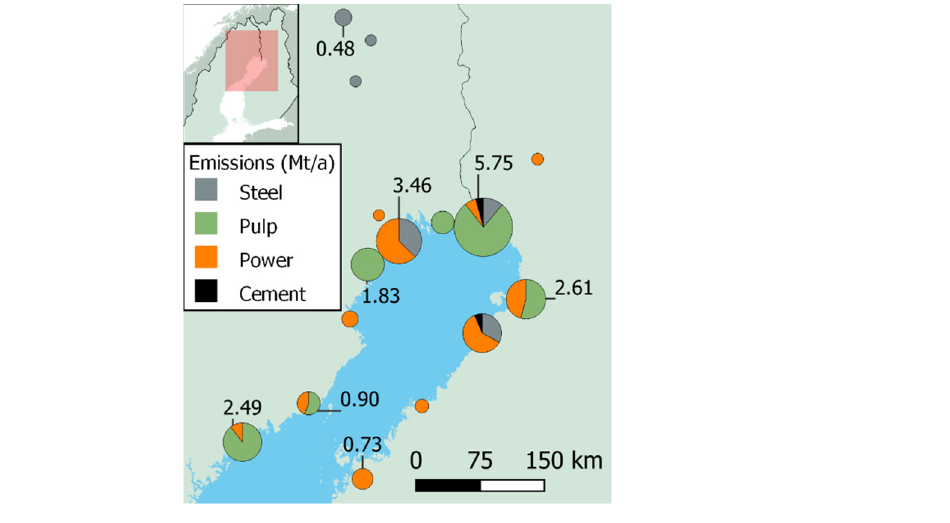
2 from the region (data from